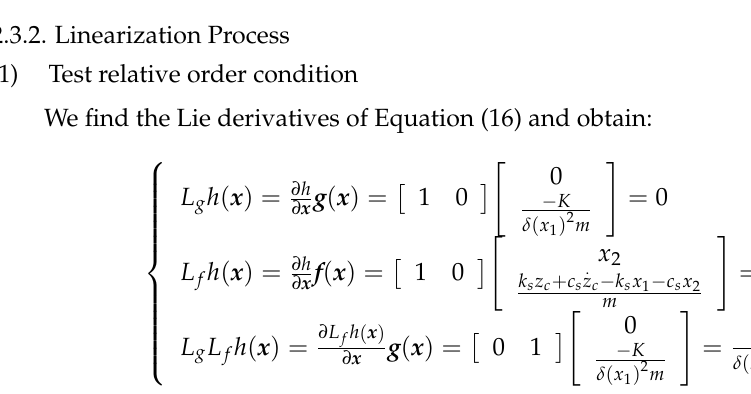
Figure 6. Open-loop structure of second-order system.